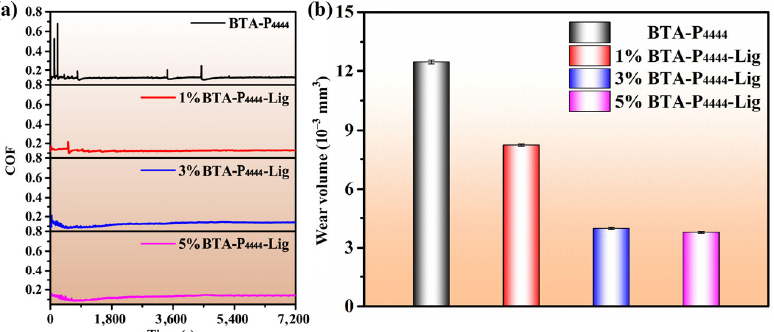
Fig. 6 COF evolution and WVs of BTA-P 4444 -Lig as a lubricant for steel/steel friction pairs (test conditions: 300 N, 50 Hz, 1 mm, 150 °C, and 120